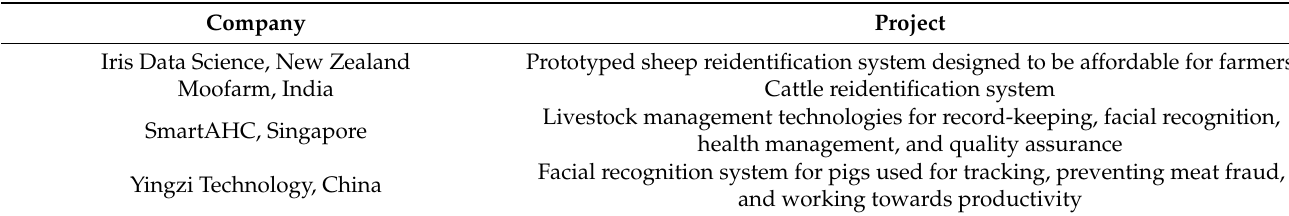
Figure 2. Potential of sensor technologies in measuring farm animal emotions. Table 4. Commercial technologies for animal